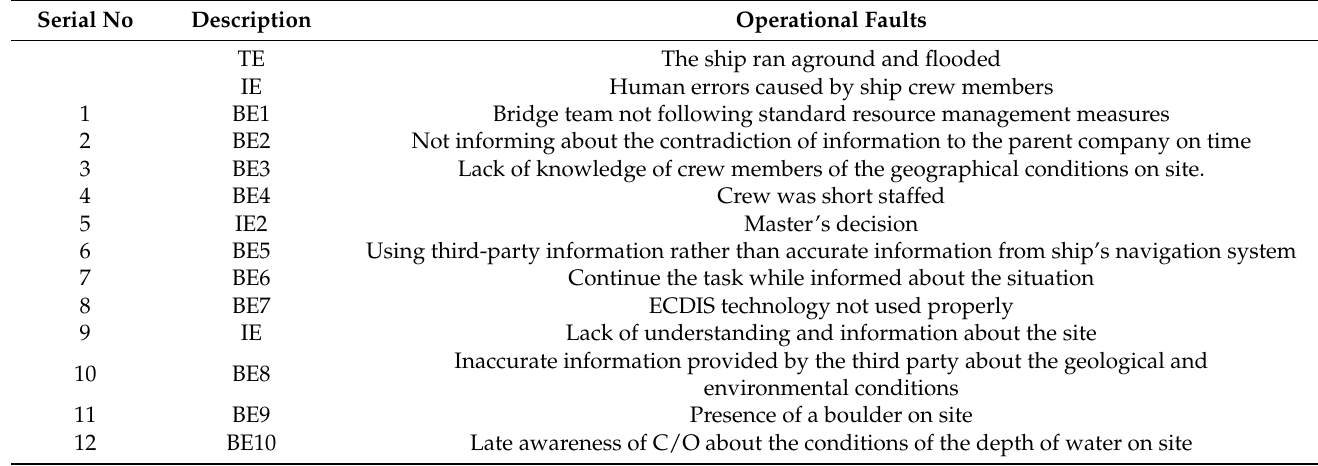
Table 3. Description of the events.